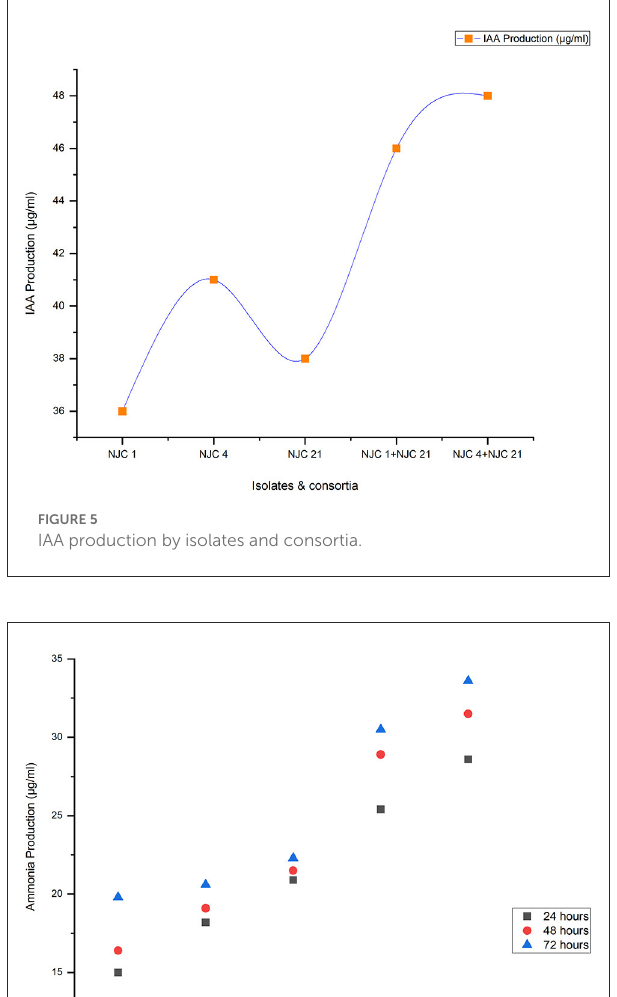
FIGURE6 Ammonia production by isolates and consortia.